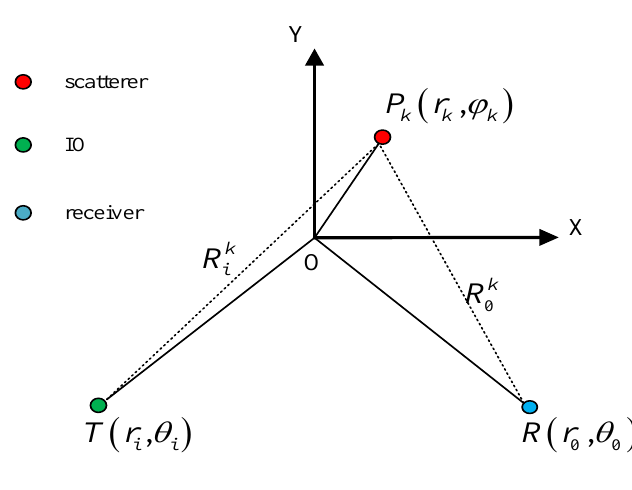
Figure 1. Passive radar imaging